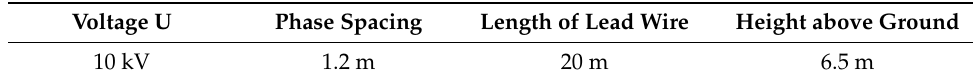
Table 1. Transmission line model parameters.